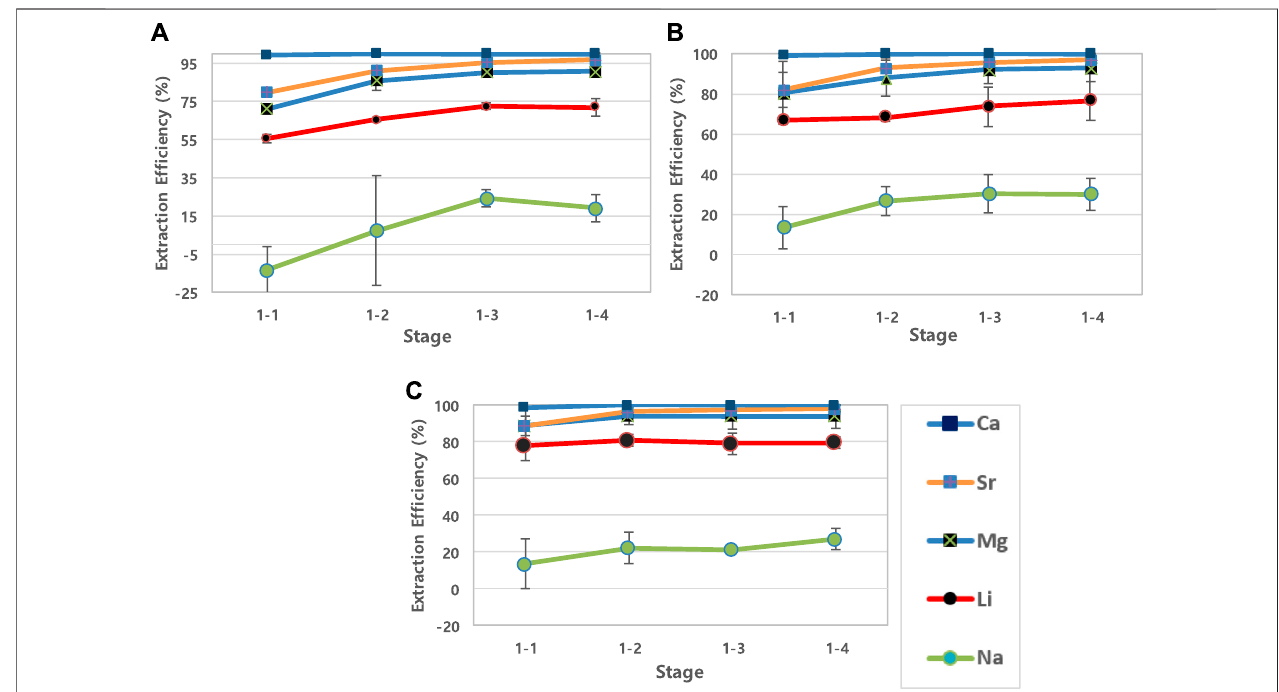
FIGURE 1 | 1 st step removal ef fi ciency of cations in different SiO 2 concentrations of geothermal water. (Sample (A) -SiO 2 0 mg/L; Sample (B) -SiO 2 150 mg/L; Sample (C) -SiO 2 350